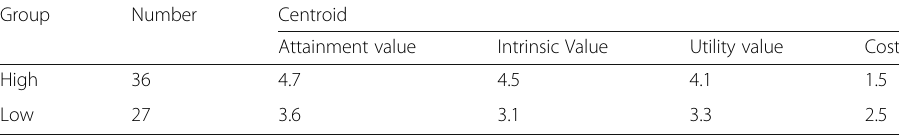
Table 2 Grouping based on participants ’ academic motivation Group